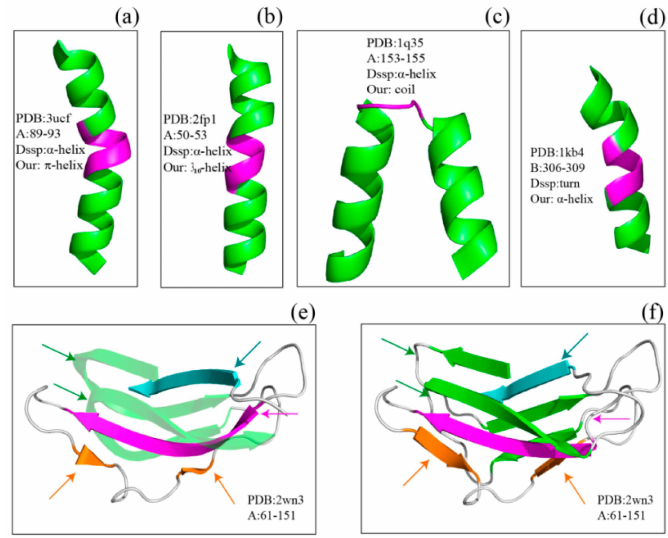
Figure 2. Examples of disagreement between SACF and DSSP. ( a – d ) show difference in helix assignment between SACF and DSSP while ( e , f ) illustrate the difference in β -sheet. The divergently assigned regions are shown in magenta in the top four panels and are labeled with arrows in the bottom two panels. The PDB ID and residue number are labeled in the figures, and we also provide the hydrogen bond information for ( a , b ) (Figure S1).